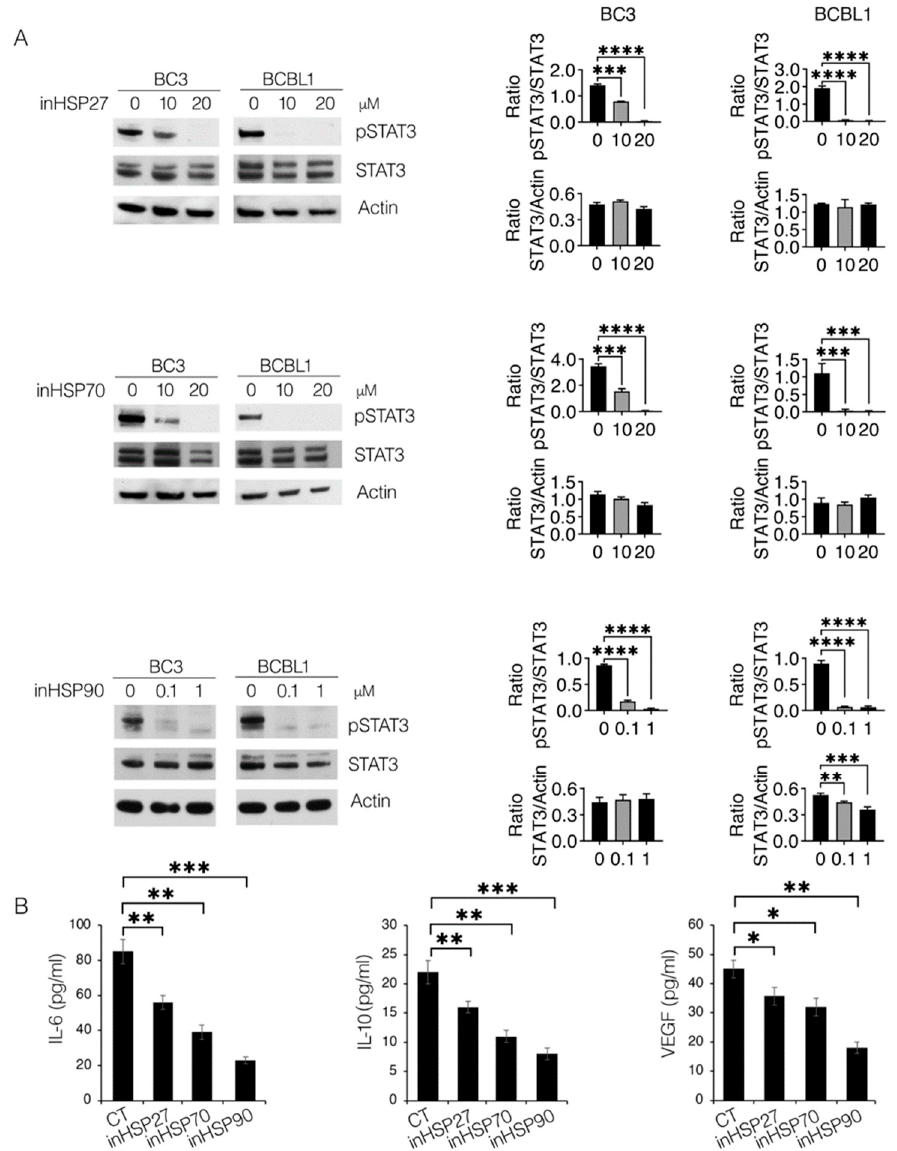
Figure 3. HSP inhibition reduces STAT3 activation and cytokine release in PEL cells. BC3 and BCBL1 cells were treated with inHSP27 (J2) (10–20 µ M), inHSP70 (PES) (10–20 µ M) or inHSP90 (17AAG) (0.1–1 µ M) for 24 h and ( A ) protein phosphorylation of STAT3 was evaluated by Western blot analysis. Actin was used as a loading control and one representative experiment is shown. The histograms represent the densitometric analysis of the ratio of specific protein/actin. Data are represented as the mean plus S.D. p value: ** <0.01; *** <0.001; **** <0.0001. ( B ) After treatment with inHSP27 (10 µ M), inHSP70 (10 µ M) or inHSP90 (0.1 µ M), supernatants from BC3 were collected and analyzed for IL-6, IL-10 and VEGF amount by a Luminex Assay. Histograms representing the mean ± S.D. of the three independent experiments. p -value: * <0.05; ** <0.01; ***